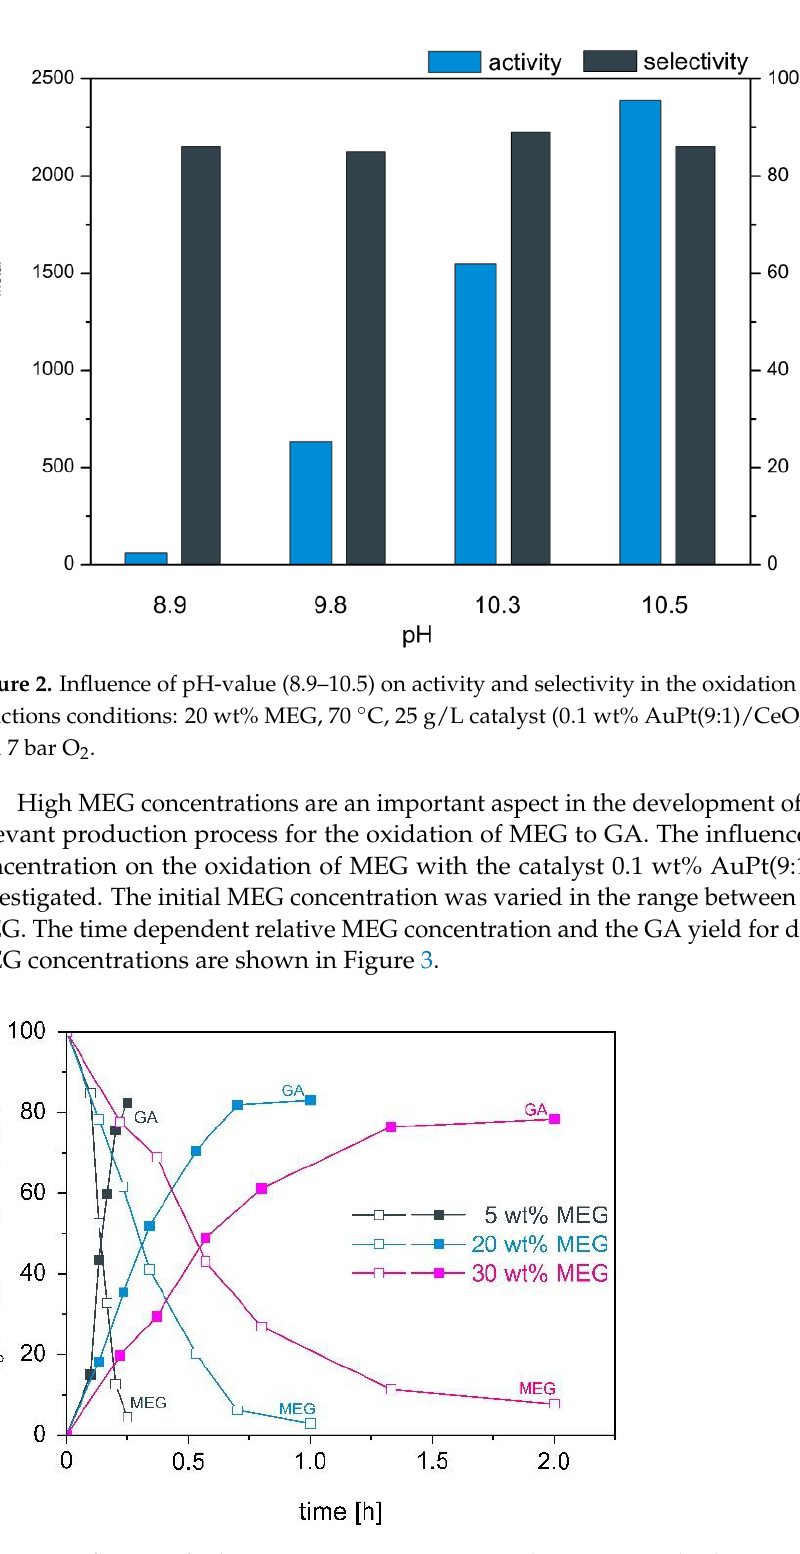
Figure 3. Influence of relative MEG concentration on the activity and selectivity of the catalyst 0.1 0.1 wt% AuPt/CeO 2 in the oxidation of MEG to GA. Reaction conditions: 5–30 wt% MEG, 70 ◦ C, wt% AuPt/CeO 2 in the oxidation of MEG to GA. Reaction conditions: 5 – 30 wt% MEG, 70 °C, 25 g/L 25 g/L 0.1 wt% AuPt(9:1)/CeO 2 , pH 10.5, 7 bar O 2 0.1 wt% AuPt(9:1)/CeO 2 , pH 10.5, 7 bar O 2 .